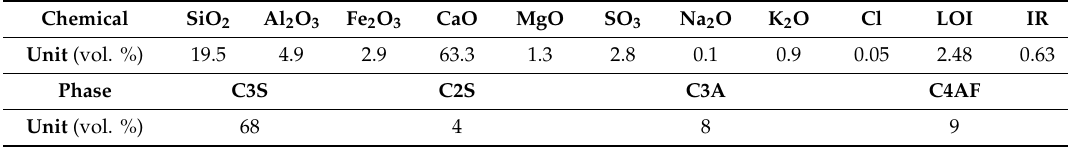
Table 1. Chemical and phase composition of